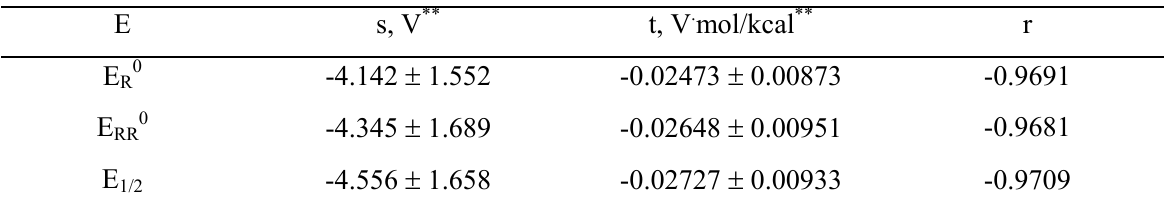
values ( vs saturated Hg 1/2